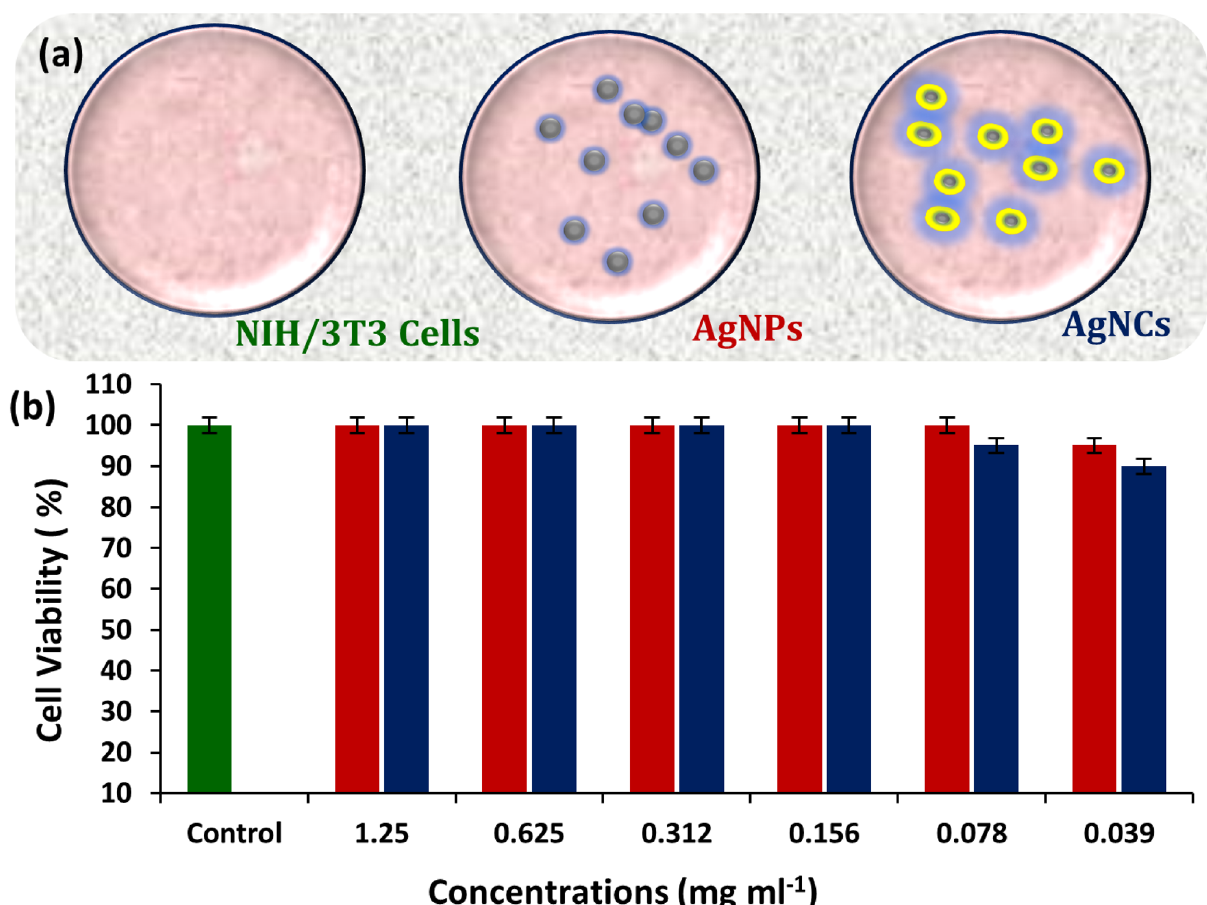
Figure 7. Cell cytotoxicity analysis on the viability of NIH/3T3 cells using MTS assay. ( a ) schematic presentation of cell viability. ( b ) effect of different concentrations of the developed silver nanoparticles (AgNPs) and the silver nanocomposite system